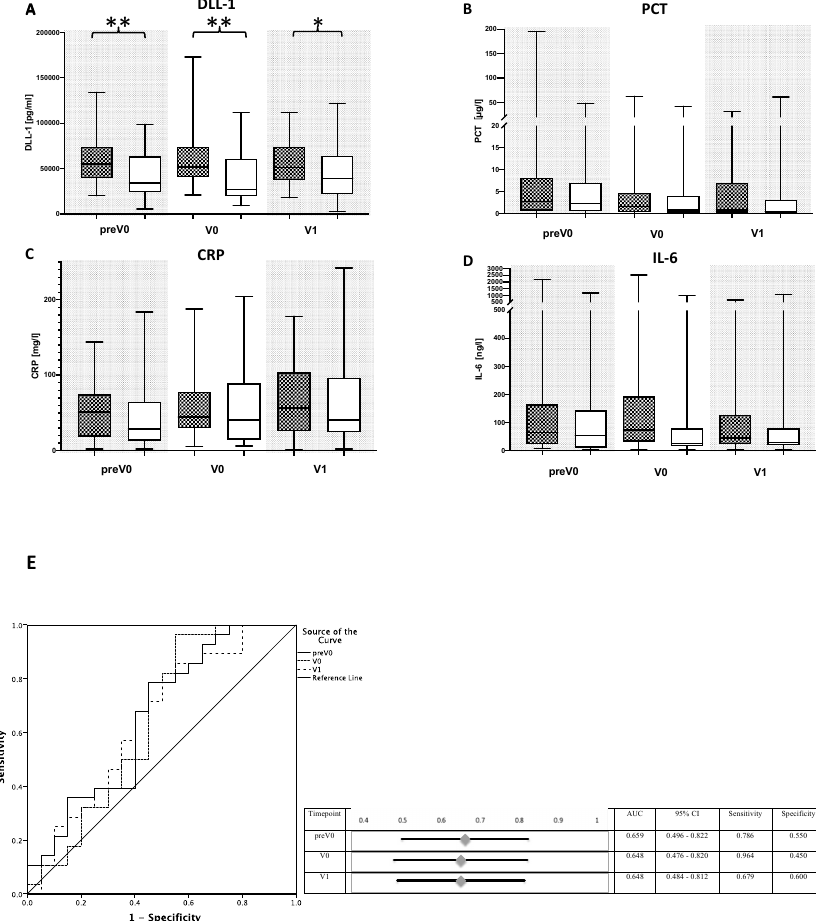
Figure 4. Delta-like Canonical notch ligand 1 (DLL1) for the recognition of bacterial infections matched to the timepoint of the first bacterial findings. Plasma concentrations of ( A ) Delta-like Canonical notch ligand 1 (DLL1), ( B ) procalcitonin (PCT), ( C ) C-reactive protein (CRP), and ( D ) interleukin (IL-)6 were measured in patients following LTX with a bacterial infection (black-checkered box) or without (white box). In patients with a bacterial infection, timepoints were matched to the first bacterial findings, whereas the control group without a bacterial infection was matched to patient´s individual age and sex related to the same timepoints. The following new virtual timepoints were created: first measurement before the first bacterial infection (preV0), the plasma level at time of the bacterial infection (V0), and next following measured plasma level (V1). Data presentation: box plots with median, 25th percentile and 75th percentile in the box, as well as with the 10th and 90th percentiles at the end of the whiskers. Symbols of significance: p < 0.05: *, p < 0.01 **. ( E ) ROC analysis for DLL1 in bacterial infected vs. uninfected patients regarding the three virtual timepoints preV0, V0, and V1, which are described above. Abbreviations: AUC, area under the curve; CI, confidence interval.